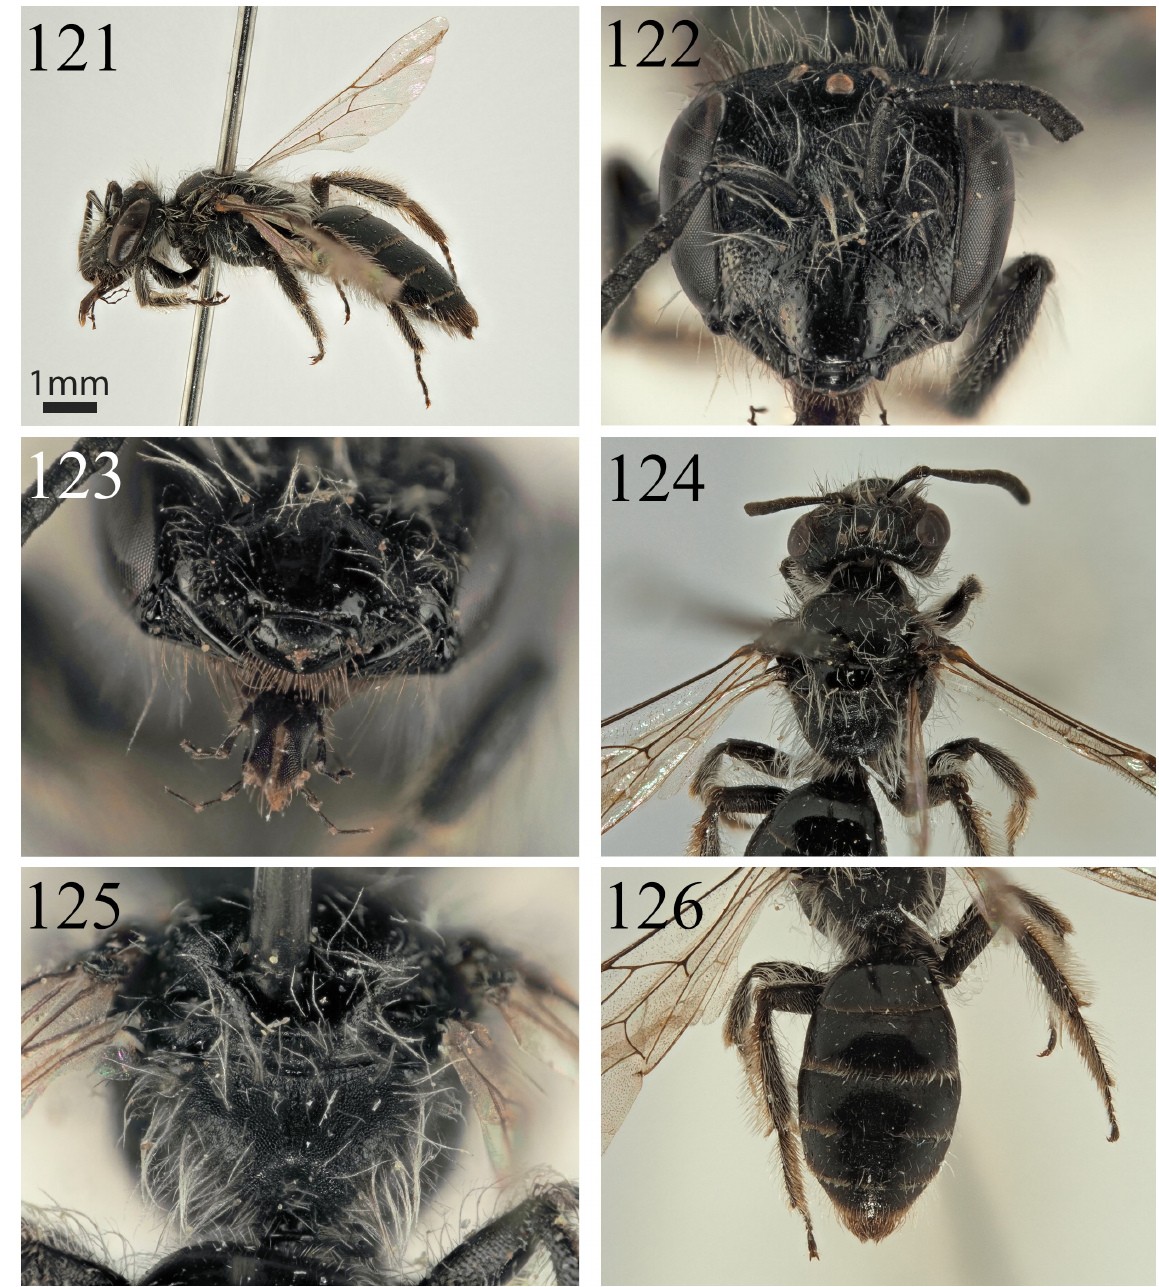
Figs 121–126. Andrena hosseiniiae sp. nov., ♀ (OÖLM). 121 . Profile. 122 . Face. 123 . Process of labrum. 124 . Dorsum. 125 . Propodeal triangle. 126